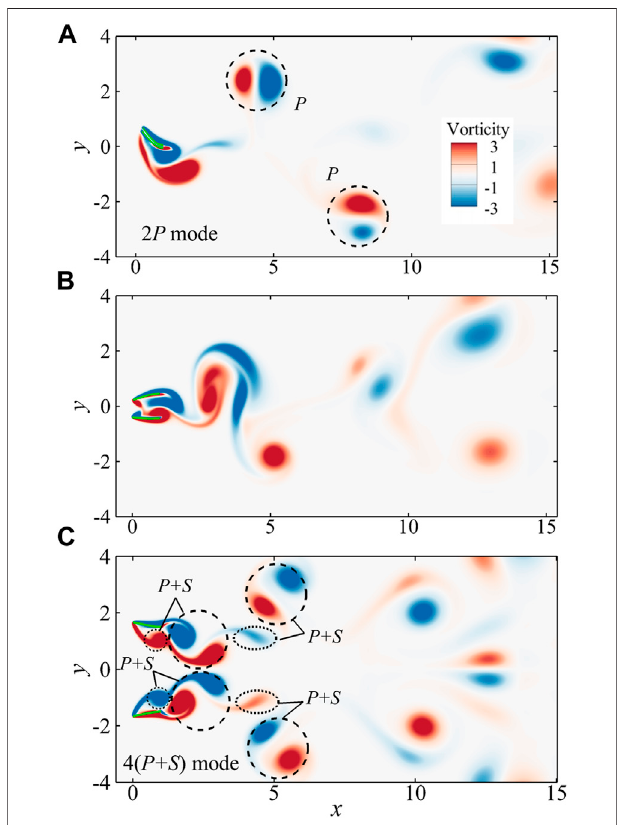
FIGURE 4 | The instantaneous vorticity contours in side-by-side con fi gurations: (A) thein-phasemodewith H =0.1; (B) thequasiout-of-phase modewith H =0.9; (C) theout-of-phasemodewith H =3.The2Pand4(P+S) mode are observed in the wakes for the in-phase and out-of-phase modes, respectively.Thevortexsheddingandmovementarenon-periodic for the quasi out-of-phase mode, which leads to an irregular wake.